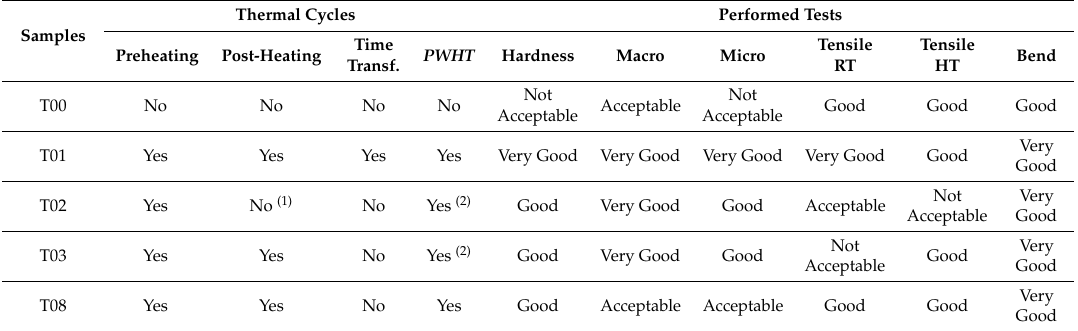
Table 10. Summary of the thermal cycles applied and corresponding results by test type. Samples